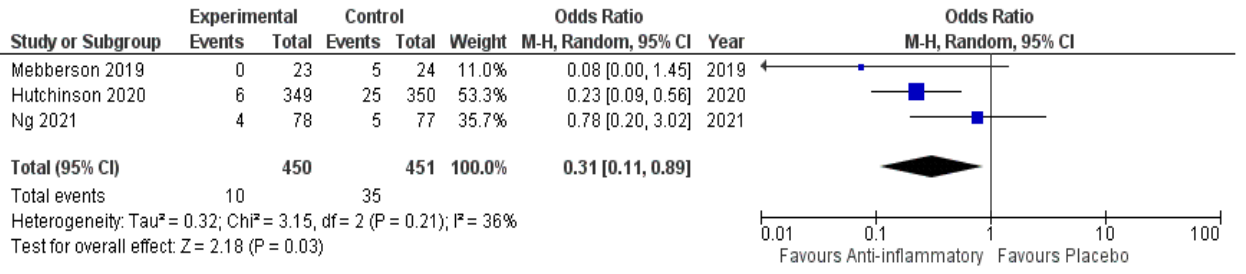
underwent surgical treatment of cSDH. Squares represent the odds ratio; the bigger the square, the greater the weight given because of the narrower 95% CI. Diamond represents the odds ratio of the overall data.